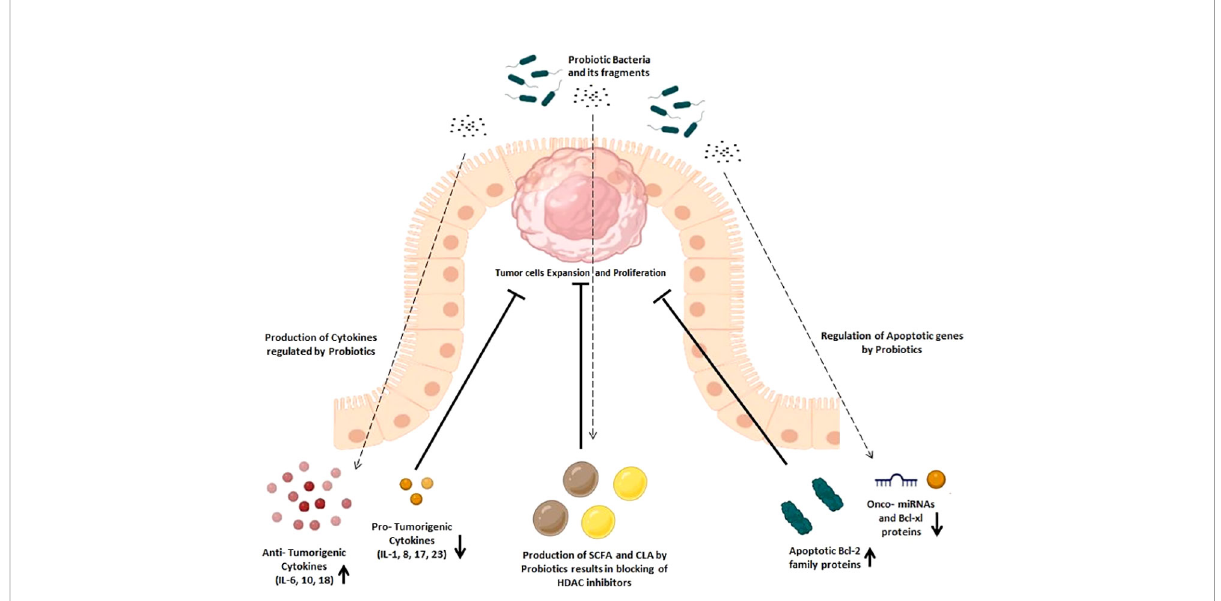
FIGURE 2 Immunomodulatory effects of probiotics in cancer prevention. Immunomodulatory effects are exhibited by the increased production of anti- tumorigenic cytokines and apoptotic Bcl-2 family proteins and the decreased production of pro-tumorigenic cytokines, onco-miRNAs, and Bcl-xl family proteins, which later helps in inhibition of tumor expansion and